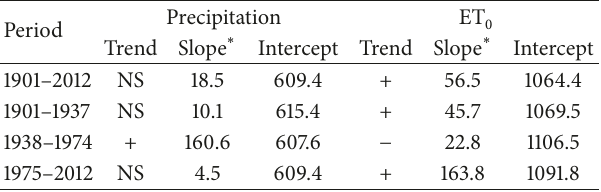
Table 1: Significance (significance level of 0.05), slope (mm/year), and intercept of trends in accumulated precipitation and ET 0 . The slope values shown were multiplied by 10 −3 . NS, nonsignificant; +, significant and positive; − , significant and